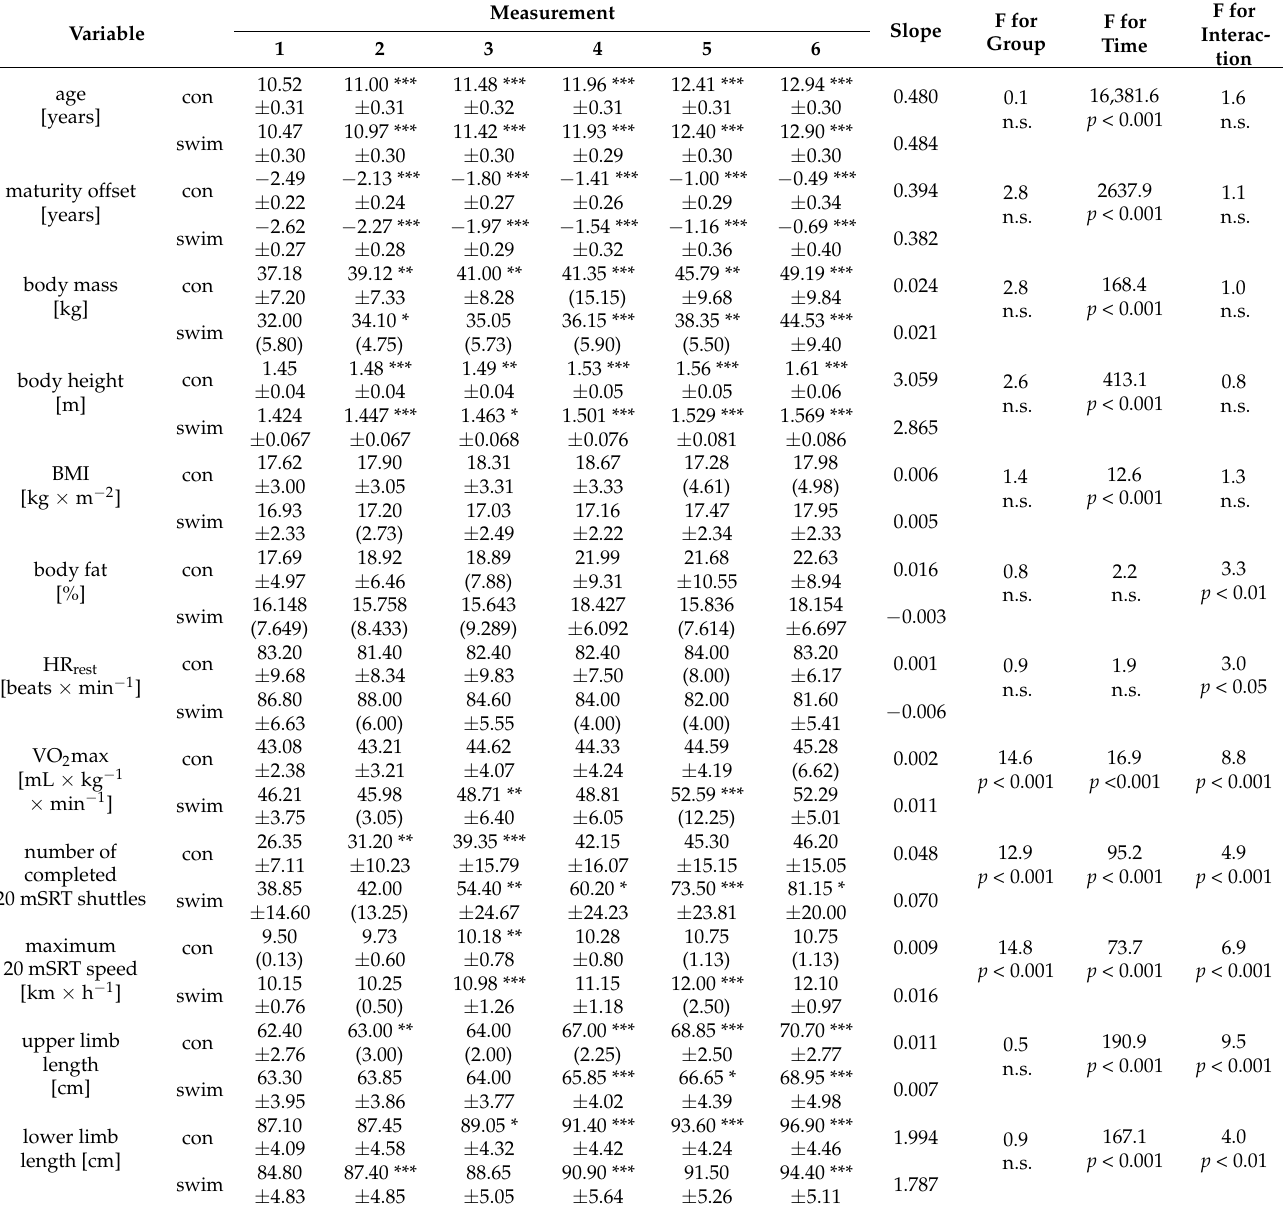
Table 1. Arithmetic means ( ± SD) or medians (IQR) of the analyzed variables for the control group (con; n = 20) and the experimental group (swim; n = 20) and the results of linear regression slopes and two-way repeated measures